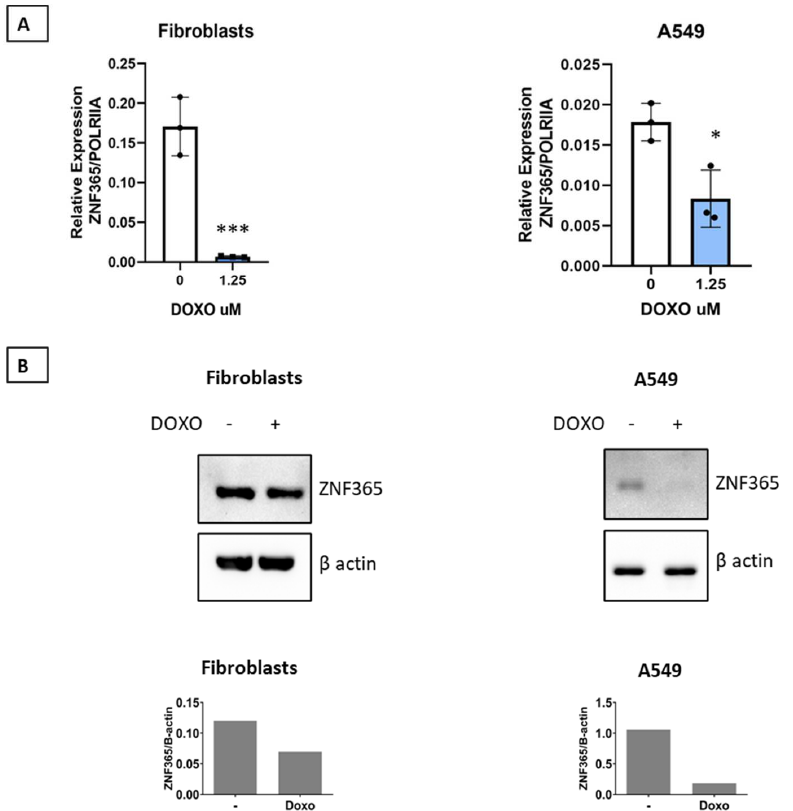
Figure 7. ZNF365 expression is significantly reduced by doxorubicin treatment. ( A ) Doxorubicin treatment reduces ZNF365 expression in normal human lung fibroblasts and A549 cells. ( B ) Western Blot analysis showing ZNF365 downregulation after 48 h of doxorubicin treatment; β actin was used as the internal loading control. Densitometric analysis is shown. Graphics represent the mean ± SD of one of two independent experiments. * p < 0.05, and *** p < 0.001 by two-tailed Student’s t - test.